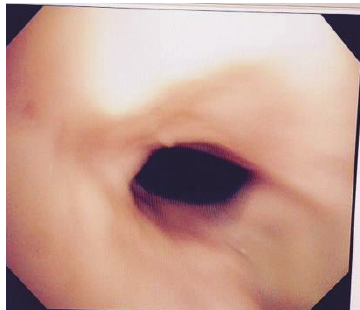
Figure 2: Trachea directly below vocal cords prior to jet of saline showing large amount of abnormal edematous greyish white mucosa.